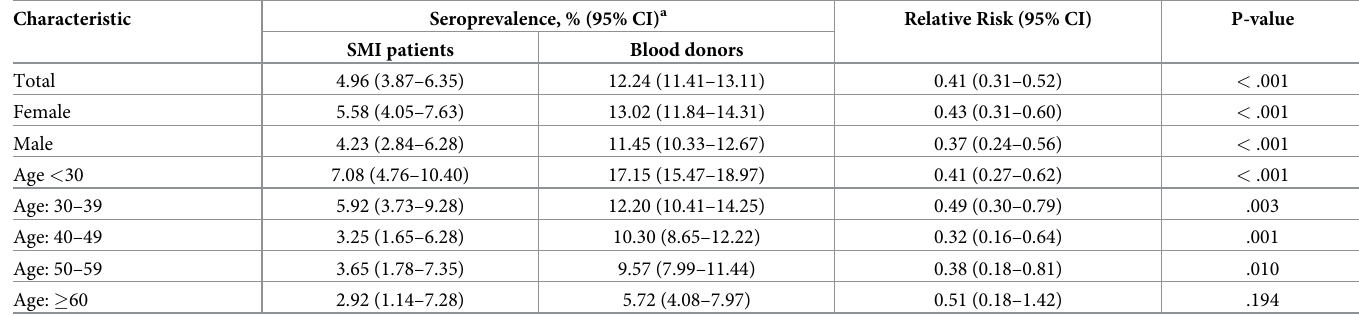
Table 4. Seroprevalences and RRs for the total group and according to gender and age group for study participants and blood donors.